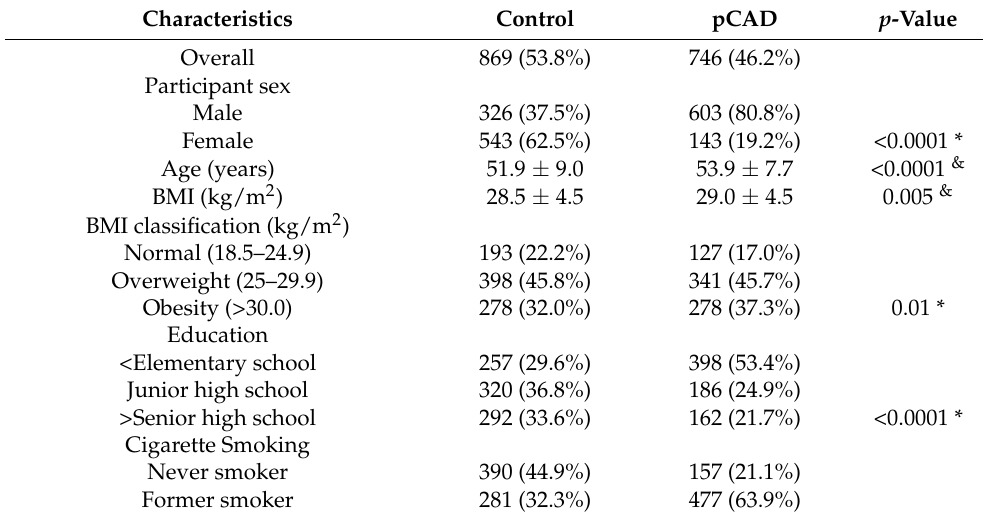
Table 1. Characteristics of pCAD patients and controls from the Genetics of Atherosclerotic Disease (GEA) Mexican